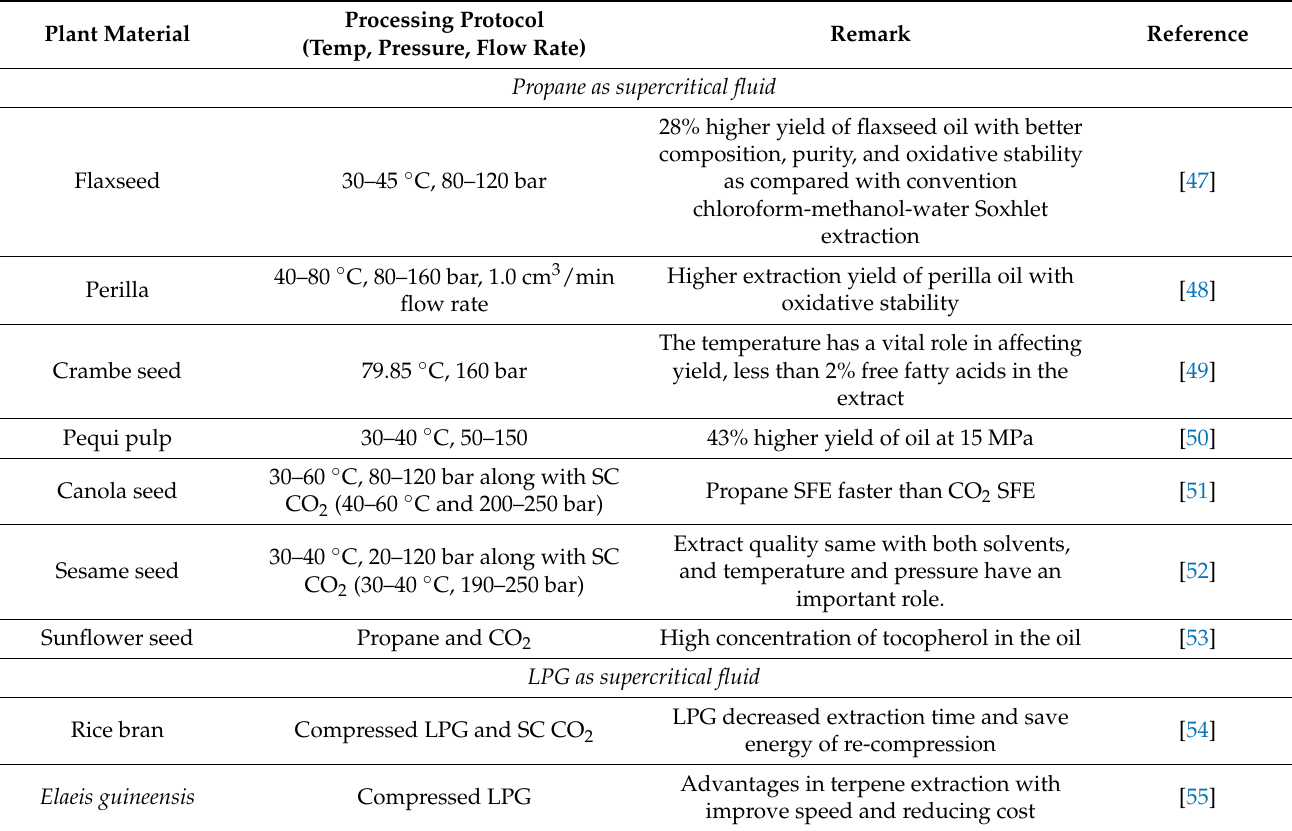
Table 2. Use of propane and LPG as supercritical fluid in the extraction of bioactive compounds. Plant